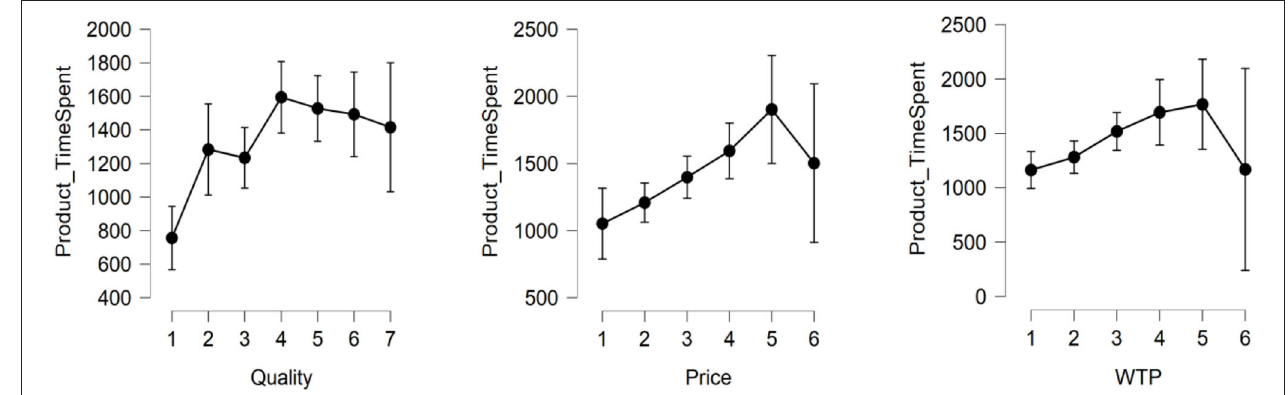
FIGURE 5 | Plots for the product time spent for quality, price, and